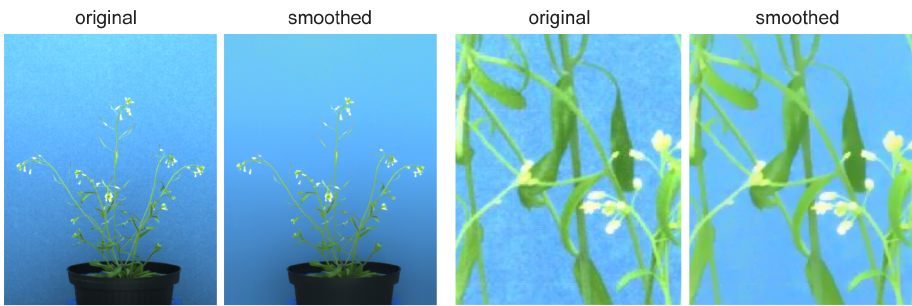
Figure 4. Examples of structure-/edge-preserving denoising of arabidopsis side-view images using Laplace smoothing.